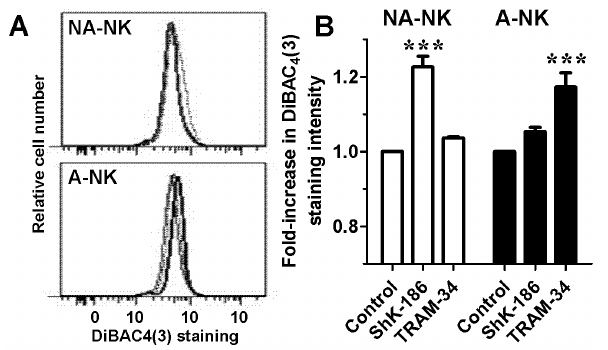
Figure 6. Blocking KCa3.1 and Kv1.3 differentially affects the membrane potential of A-NK and NA-NK cells. A: Representative flow cytometric histograms comparing DiBAC 4 (3)-stained NA-NK (top) and A-NK (bottom) cells treated with 100 nM ShK-186 (dotted lines), 1 m M TRAM-34 (thick lines) or vehicle (thin lines). B: Effects of 1 m M TRAM-34 and 100 nM ShK-186 on DiBAC 4 (3) staining intensity in NA-NK (white) and A-NK (black) cells. Data represent the mean 6 SEM of data obtained in duplicate with cells from 5 donors.